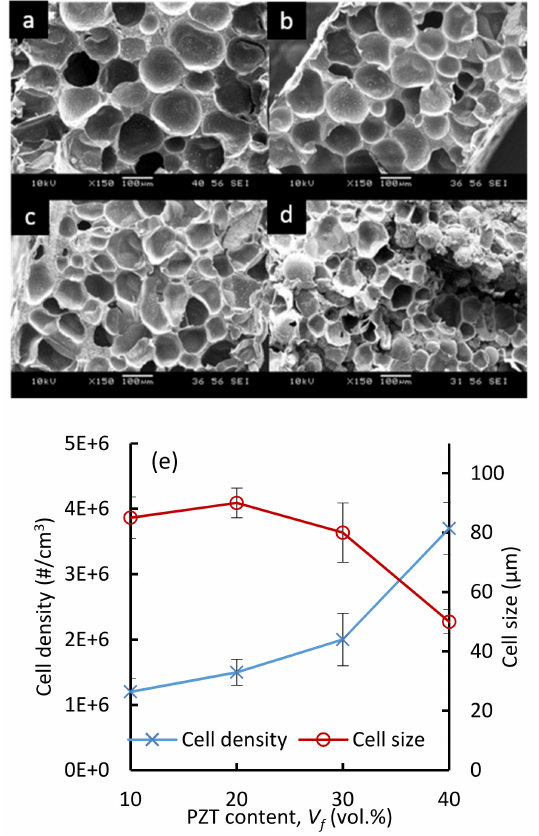
Figure 2. Scanning electron microscope (SEM) micrographs of TPU/PZT composite foams containing ( a ) 10 vol %, ( b ) 20 vol %, ( c ) 30 vol %, ( d ) 40 vol % PZT, and ( e ) average cell size and cell density